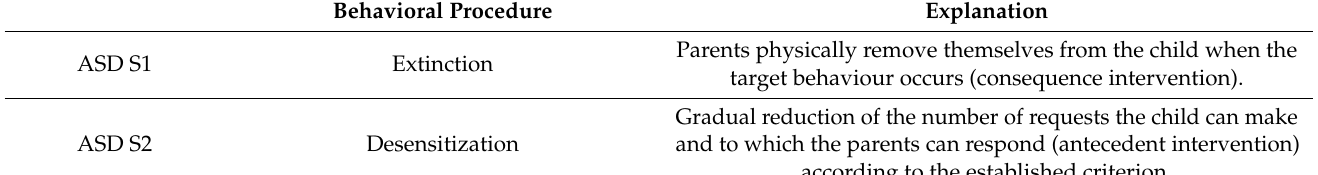
Table 5. Problem procedures and relative explanation in the ASD children enrolled